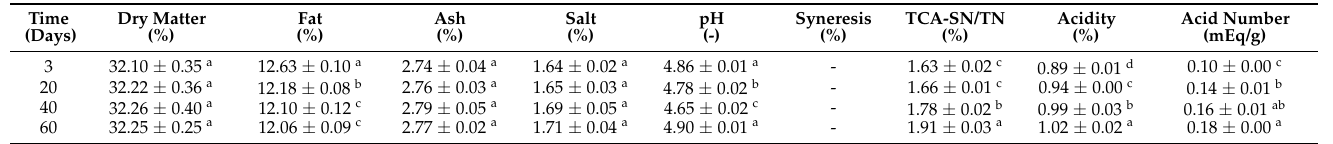
Table 4. Changes in the physicochemical properties of SBL-extract-added UF Feta-type cheese during 60 days